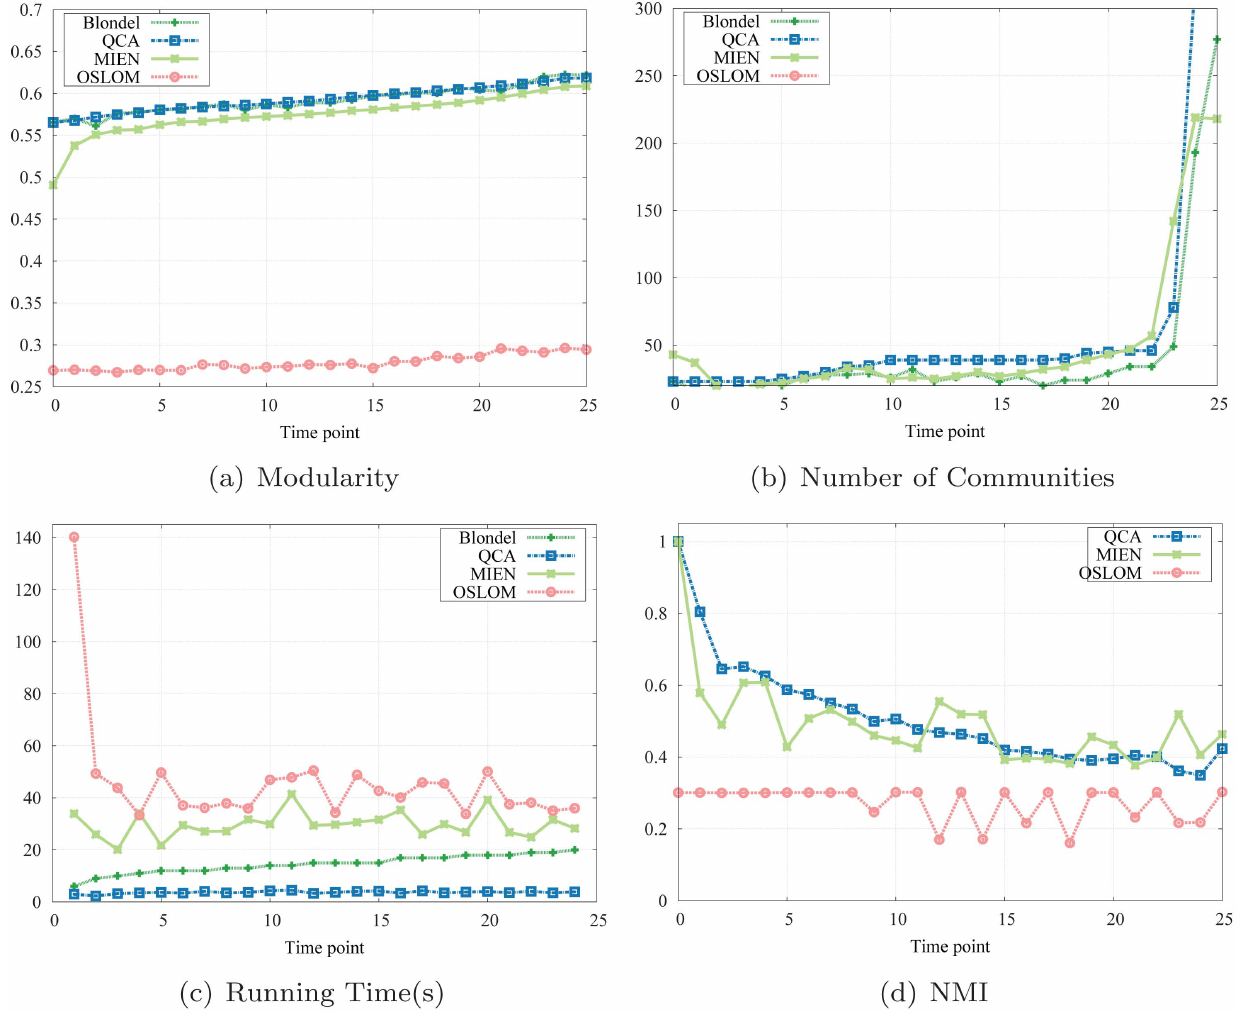
Figure 7. Simulation results on Facebook social network.